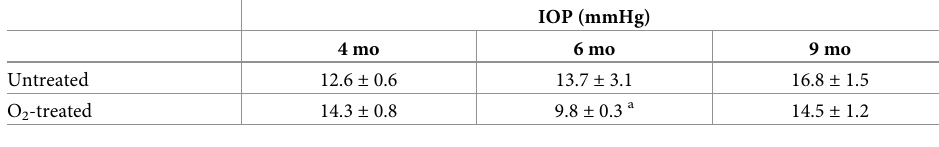
Table 1. IOP (average of left and right eyes) in untreated and 30% O 2 -treated DBA/2J mice (mean ±